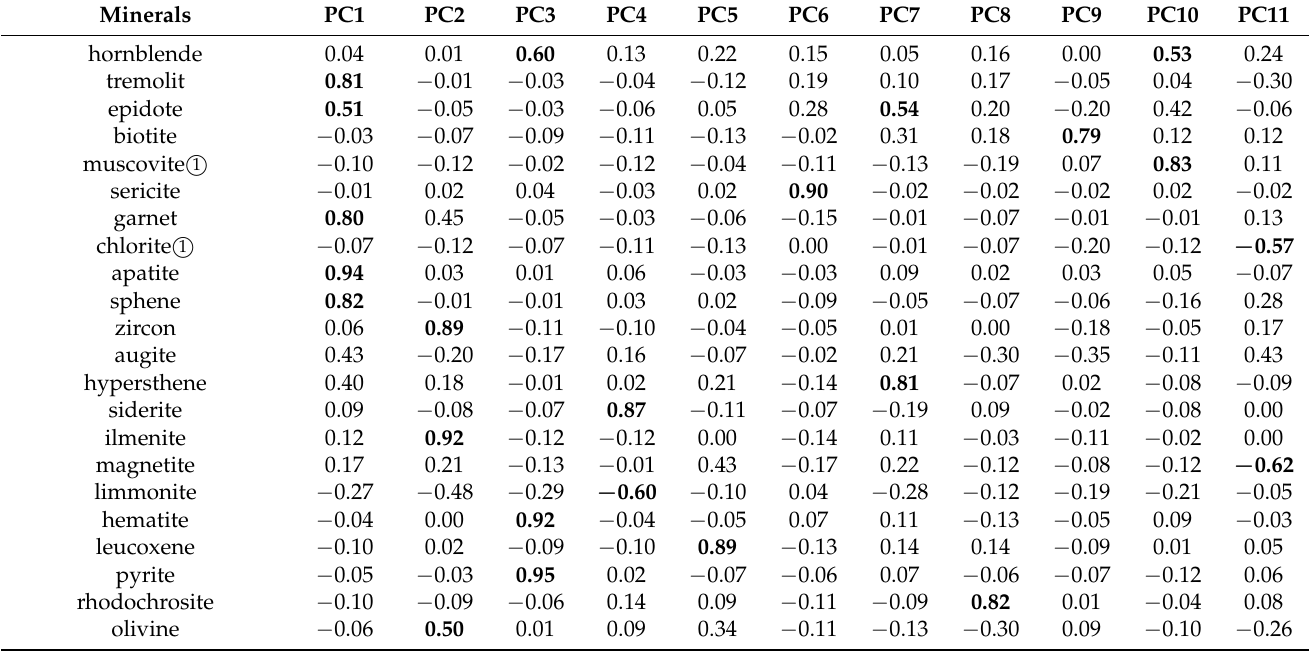
Table 3. Principal component analysis results for light and heavy minerals in the surface sediment samples from the Sunda